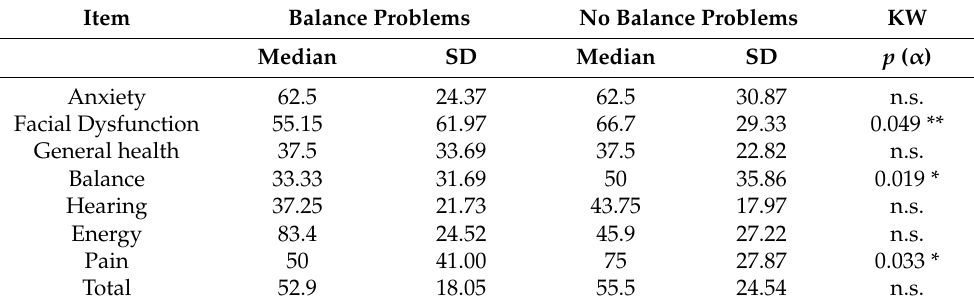
Table 6. PANQOL scores according to the presence of post-operative balance